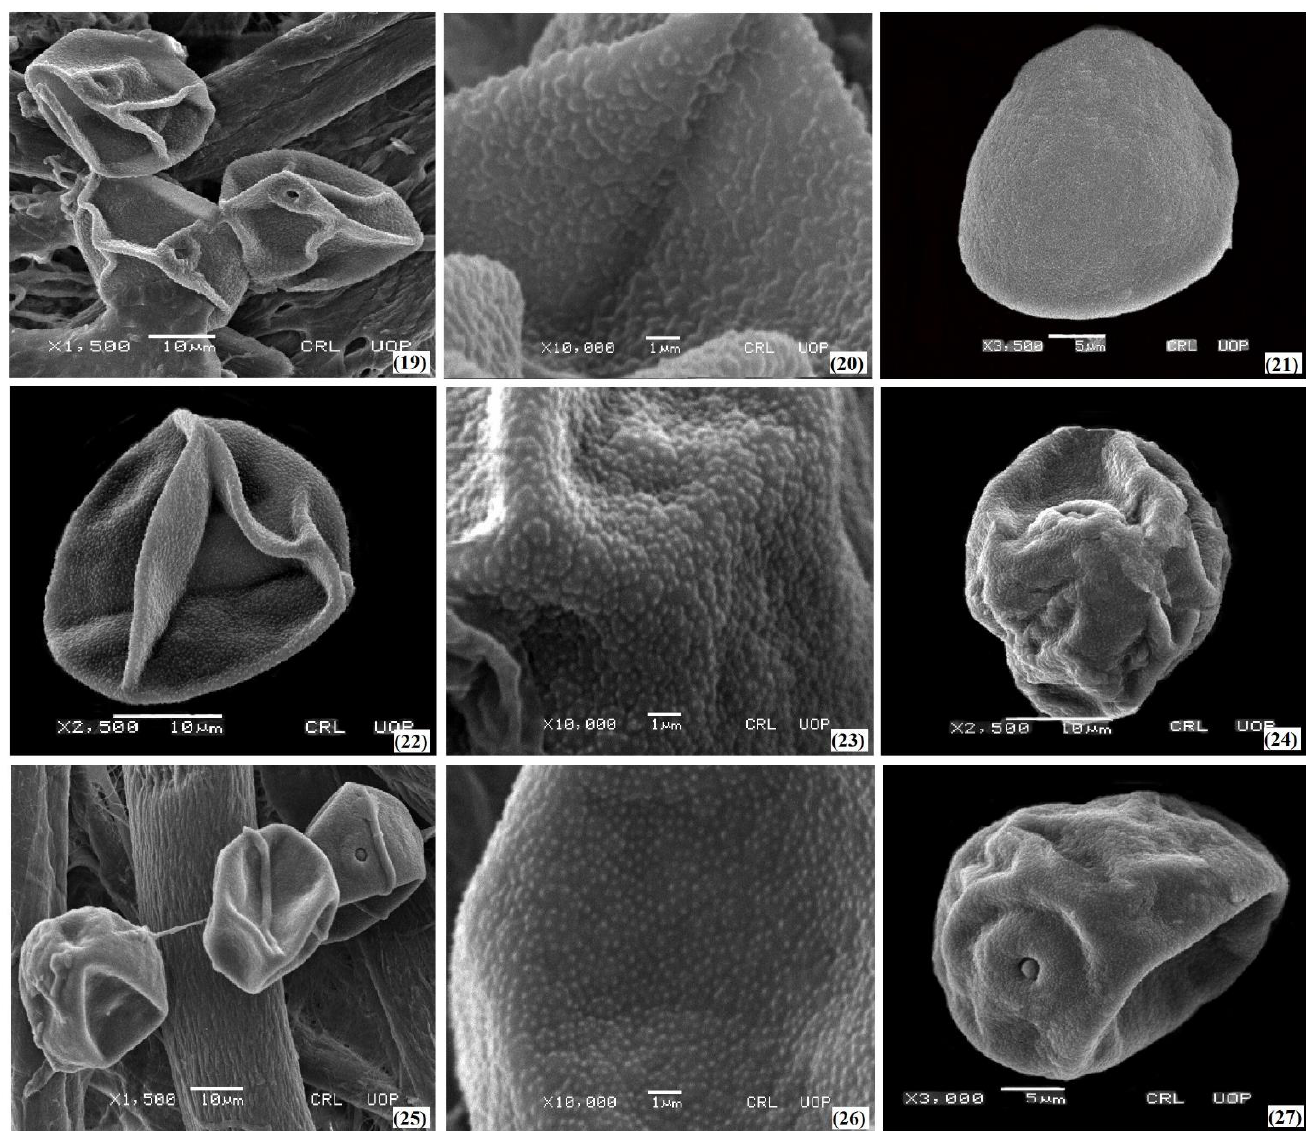
Figure 4. SEM pollen micrographs of salt tolerant grasses. Dactyloctenium aegyptium (19, 20 & 21), Echinochloa colona (22, 23 & 24), Echinochloa crus-galli (25, 26 & 27).